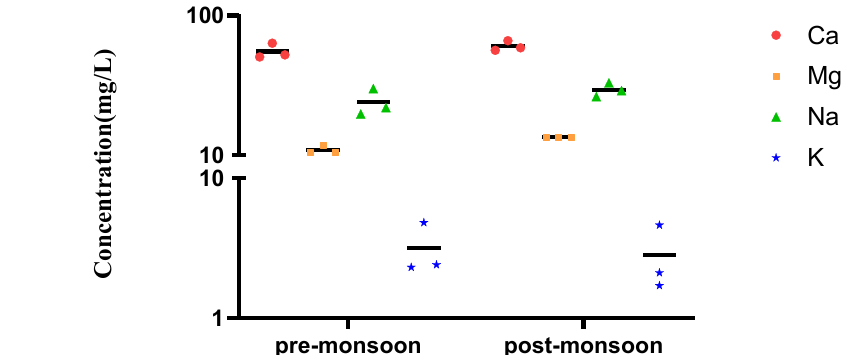
Figure 3. Detected cations concentration in groundwater samples during pre- and post-monsoon